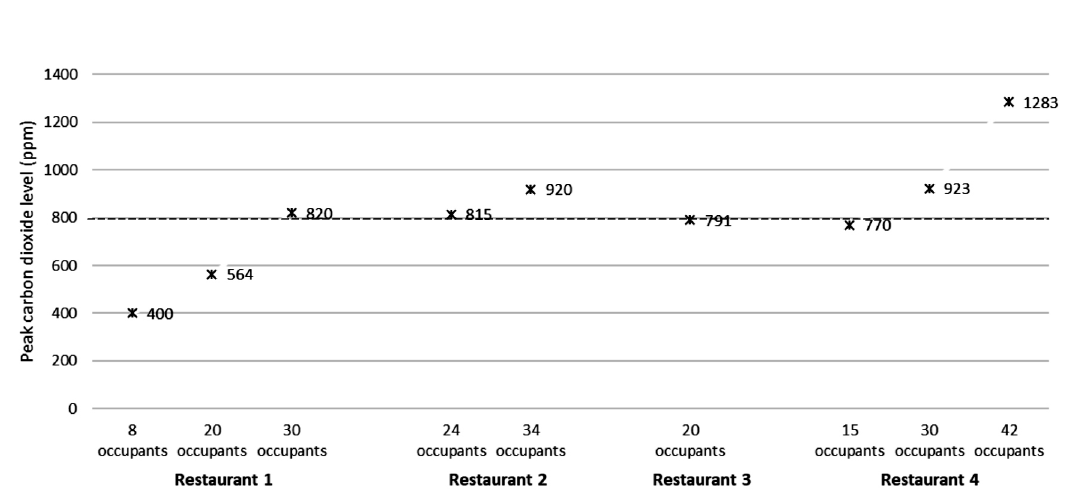
Figure 2: Restaurants . Peak carbon dioxide levels in 4 restaurants during periods with different numbers of people present, including restaurant patrons and staff. Peak levels above 800 PPM (dotted line) were considered an indicator of suboptimal ventilation for the number of occupants present. PPM, parts per